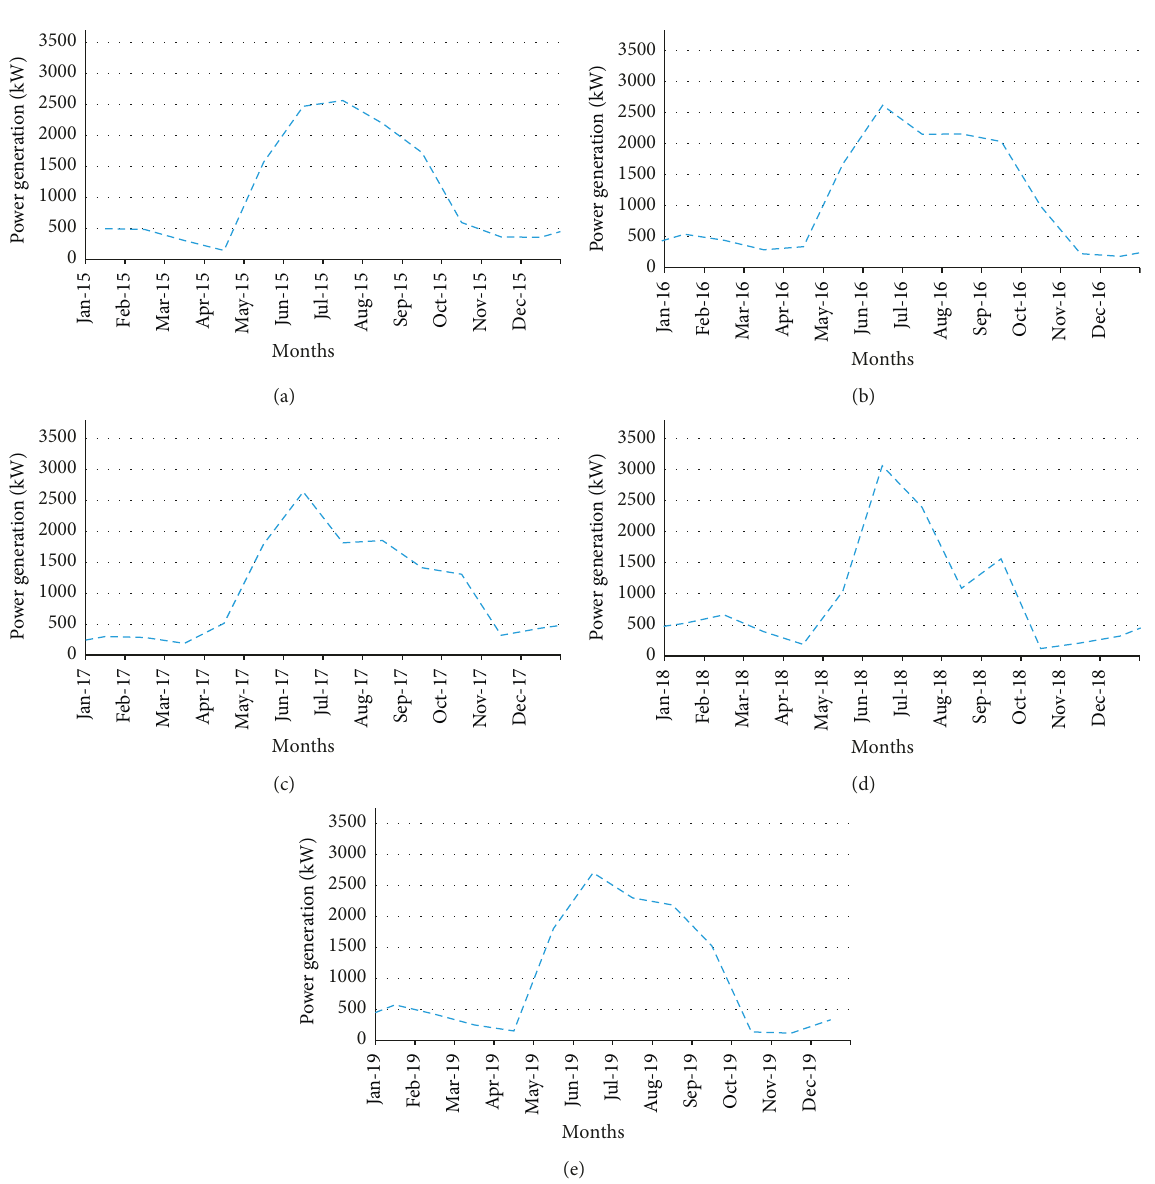
Figure 3: Power generation over the years. (a) For 2015, (b) for 2016, (c) for 2017, (d) for 2018, and (e) for